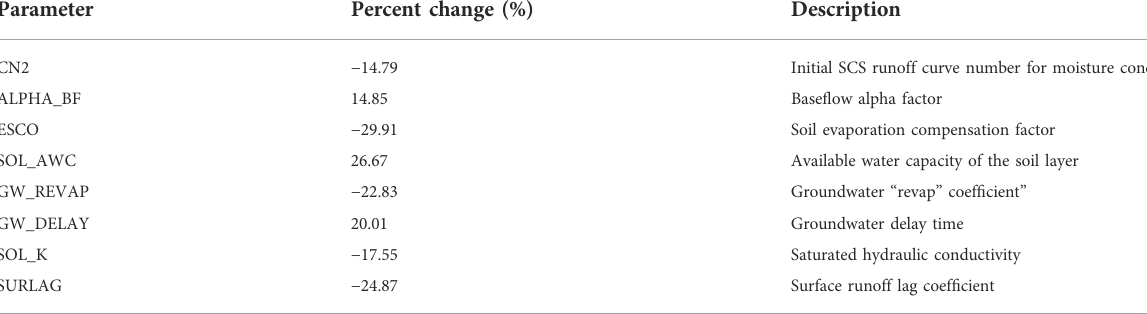
TABLE 4 SWAT CUP results, re fl ecting manually adjusted SWAT model parameters.